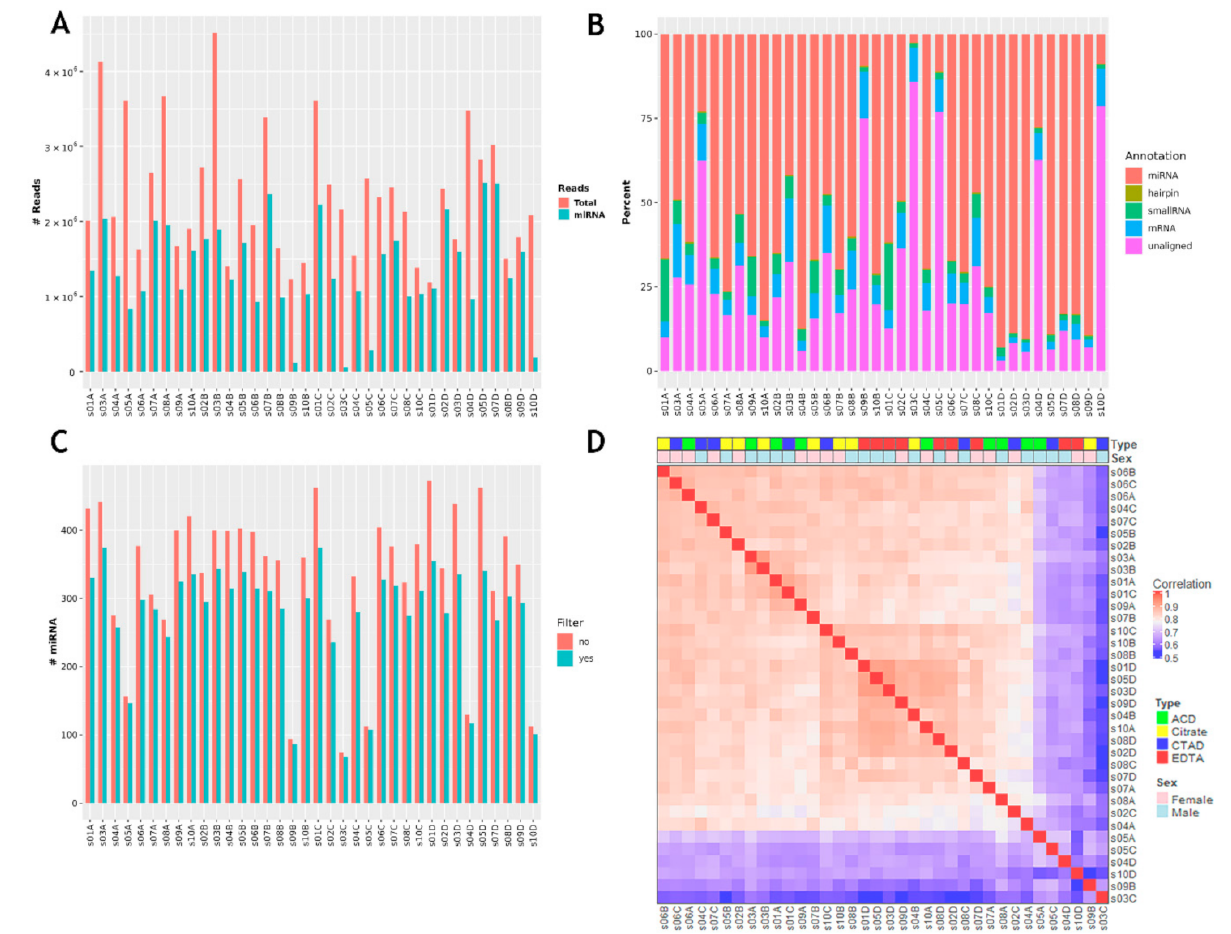
Figure 2. General output of miRNA sequencing analysis using the QuickMIRSeq pipeline. ( A ) Total and miRNA reads in each sample. ( B ) Distribution of miRNA reads compared to other types of reads. ( C ) Number of detected miRNAs per sample with and without filtering of noisy reads. ( D ) Correlation of miRNA expression between